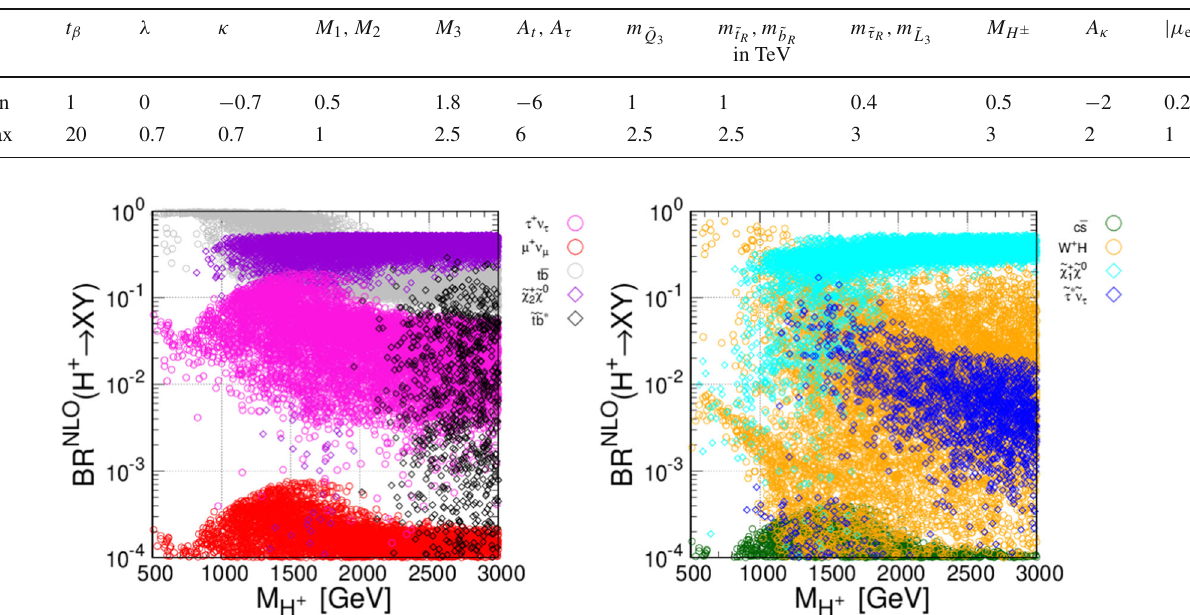
Fig. 1 Branching ratios of the charged Higgs boson H + into various final states including the NLO corrections as described in the text as a function of M H ± for all scan parameter points passing the constraints.